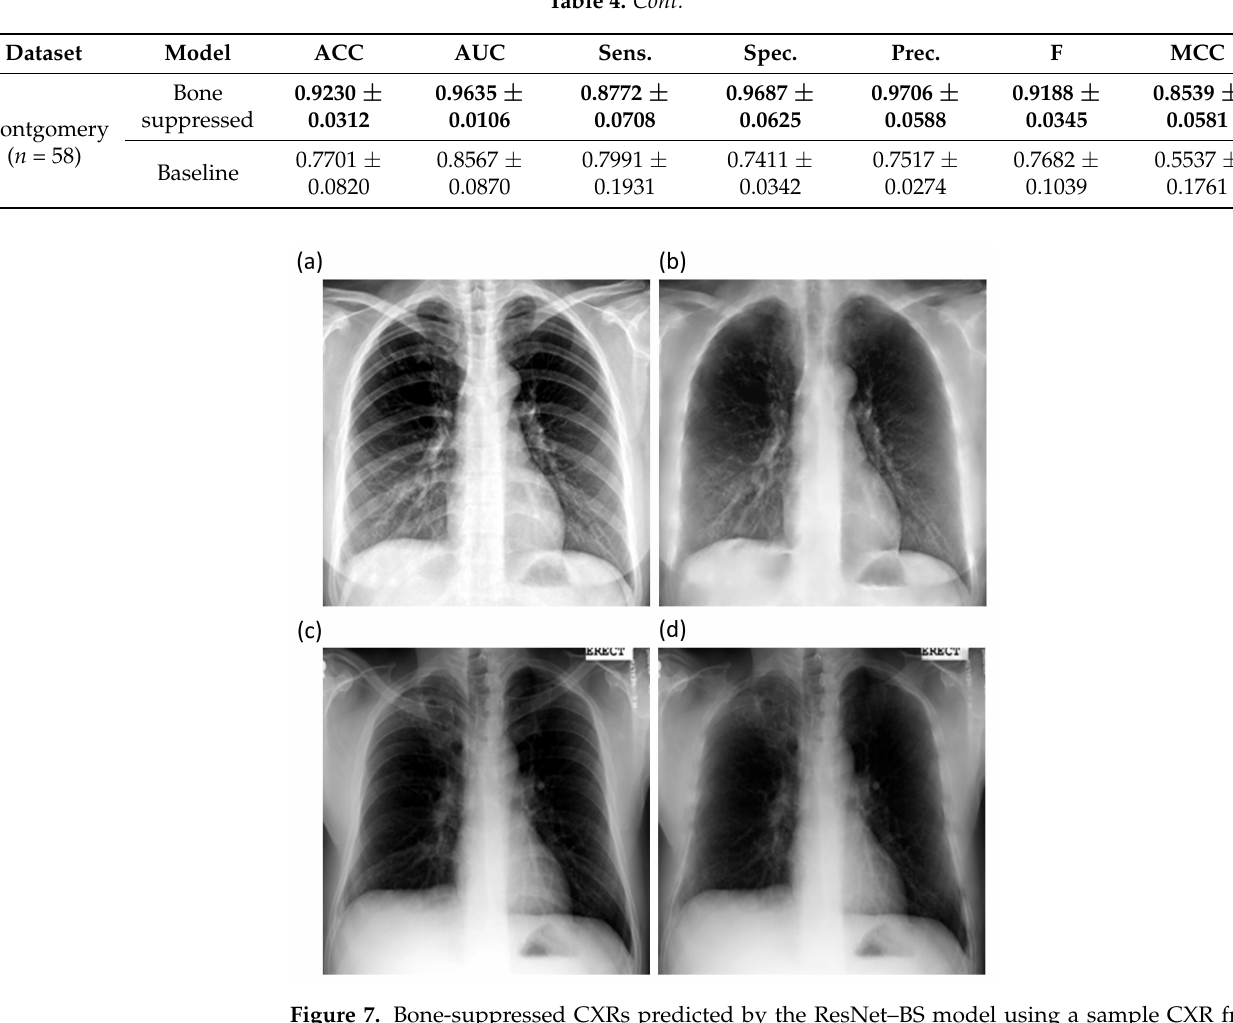
Figure 7. Bone-suppressed CXRs predicted by the ResNet–BS model using a sample CXR from the Shenzhen and Montgomery TB collection. ( a ) Shenzhen abnormal CXR; ( b ) Predicted bone- suppressed image; ( c ) Montgomery abnormal CXR; and ( d ) Predicted bone-suppressed